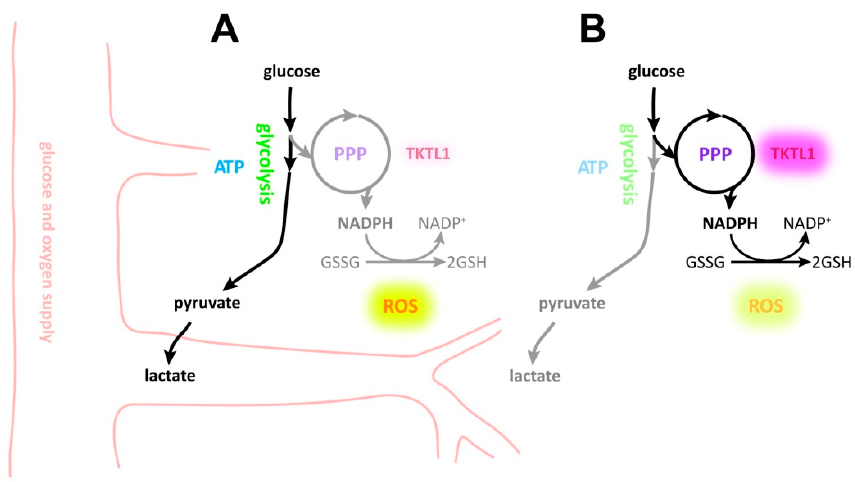
Figure 7. Outline of hypoxia-mediated effects on TKTL1 and subsequent metabolic bias. ( A ) In normoxia, TKTL1 expression does not impact ROS production and survival; ( B ) in the absence of adequate oxygen supply, TKTL1 is upregulated, accentuating the throughput of the PPP and resulting in lower ROS levels and finally less cell death.